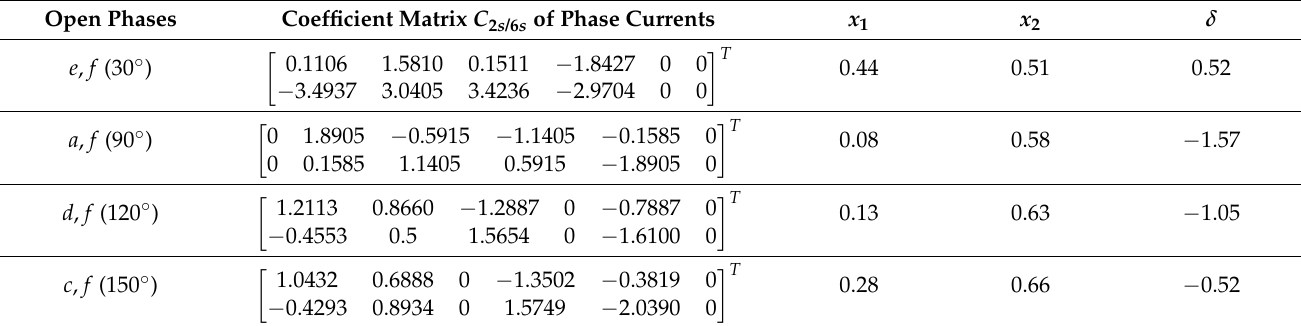
Table 2. Optimum Solutions of Phase Currents and Parameters of Matrix X Under Two-Phase-Open Fault. Open Phases